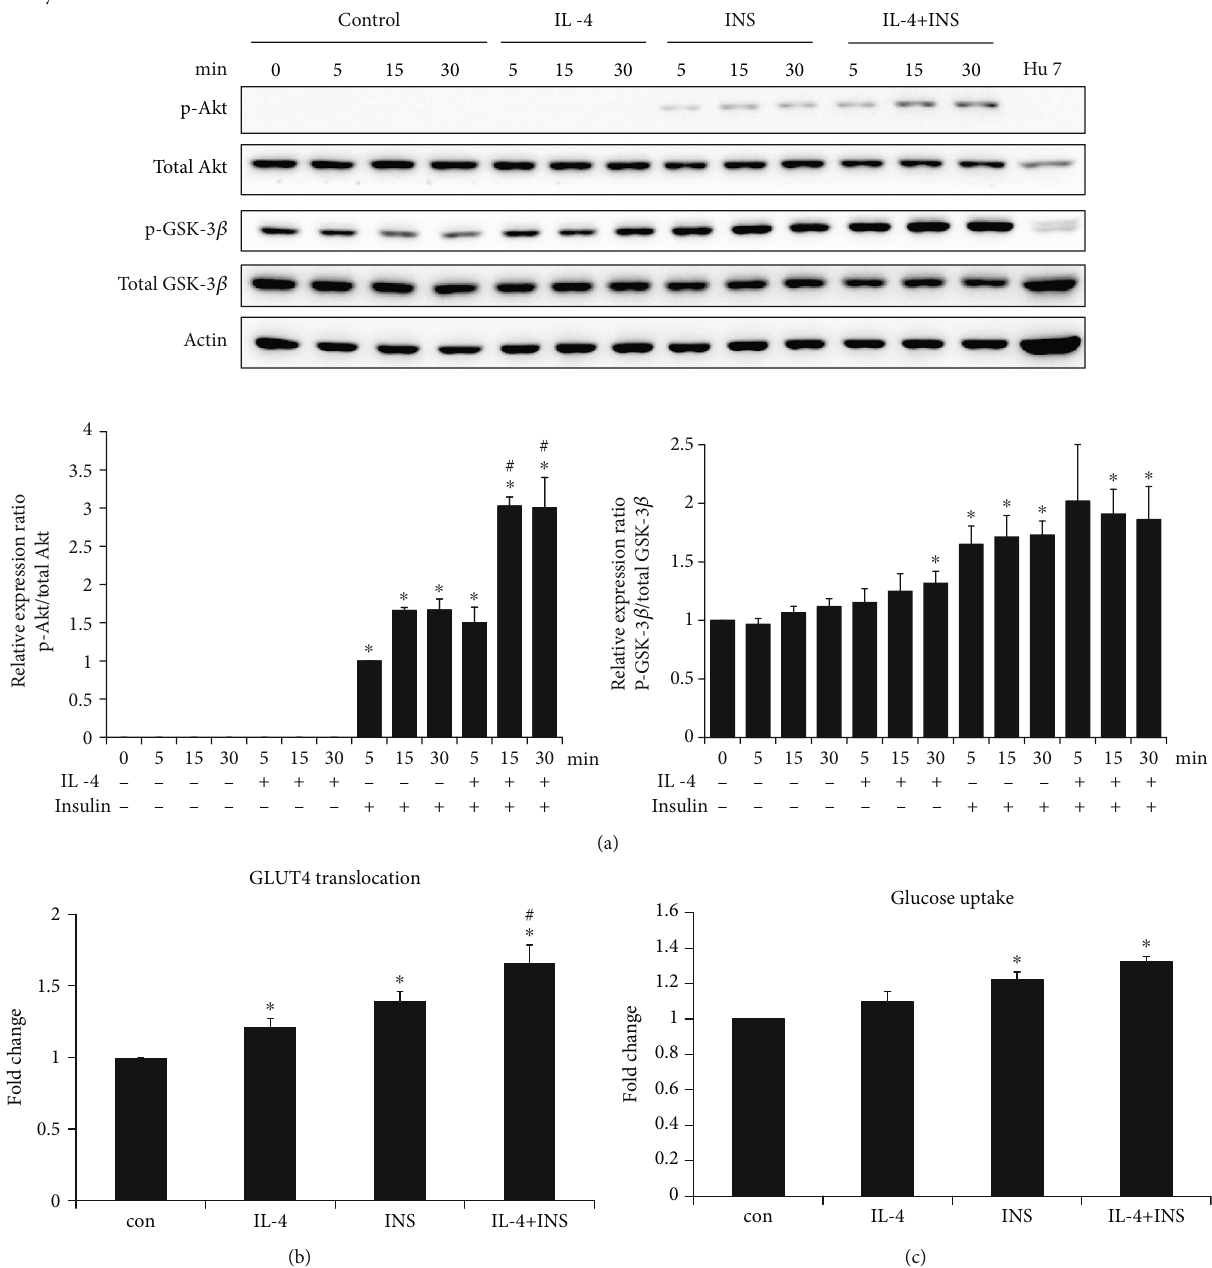
Figure 4: IL-4 promotes insulin signaling and GLUT4 translocation in C2C12 myocytes. Myocytes were transferred to serum free medium for 3 hr, followed by exposure to IL-4 and/or insulin for 30 min. (a) Cell lysate were harvested at indicated time, and levels of p-Akt and p-GSK-3 β were analyzed (n =3). ∗ p < 0 : 05 v.s 0min, # p < 0.05 v.s INS group at the same time point. (b) GLUT4 translocation and (c) glucose uptake was assayed as described in Methods (n=3). ∗ p < 0 : 05 v.s control, # p < 0.05 v.s